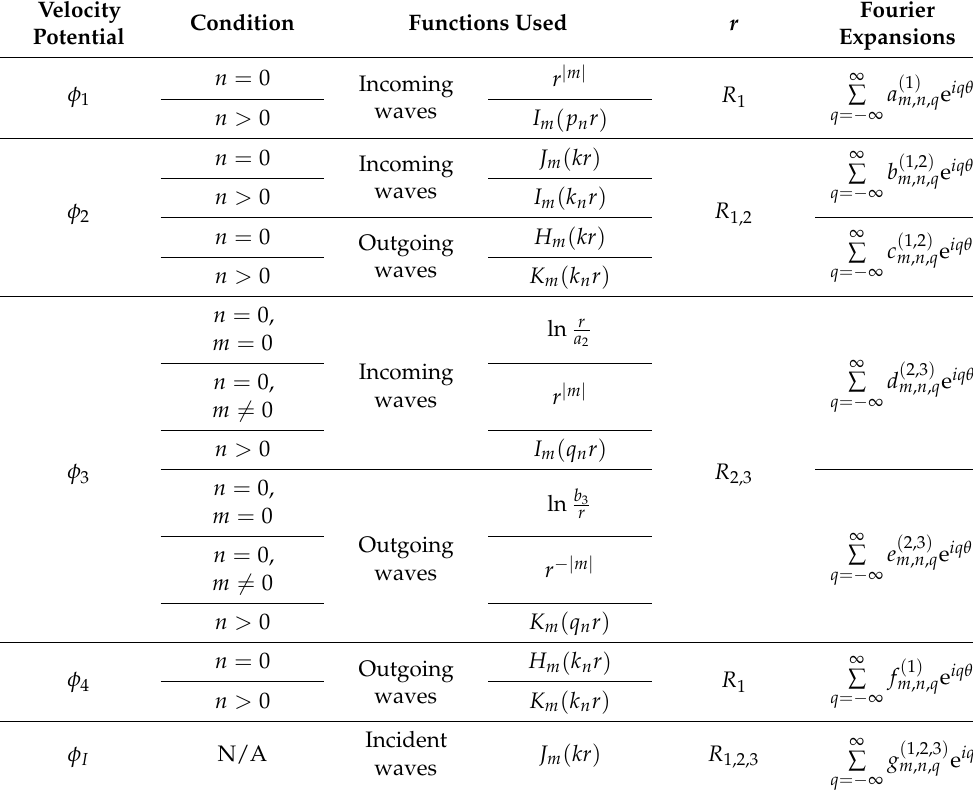
Table 2. Fourier expansions for the functions used in velocity